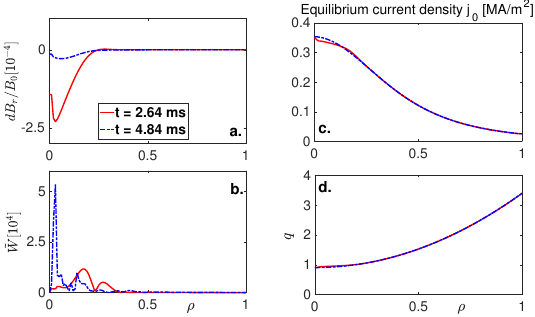
Figure 9. The profiles of the dB r / B 0 ( a ), ˜ W ( b ), equilibrium current density j 0 ( c ), and safety factor q ( d ) for the ( 1,1 ) mode case, at time t = 2.64 ms corresponding to M S = 0 (red solid lines), and t = 4.64 ms corresponding to M S = 10 − 1 (blue dotted lines).